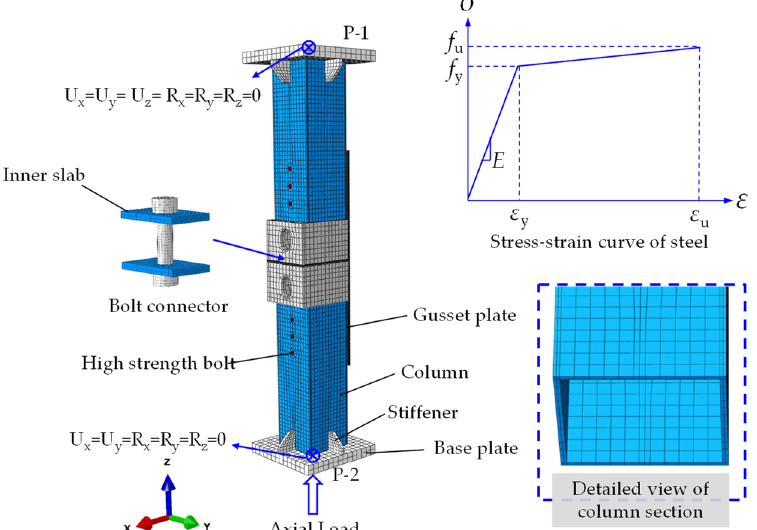
Figure 14. FEM of experimental specimens.